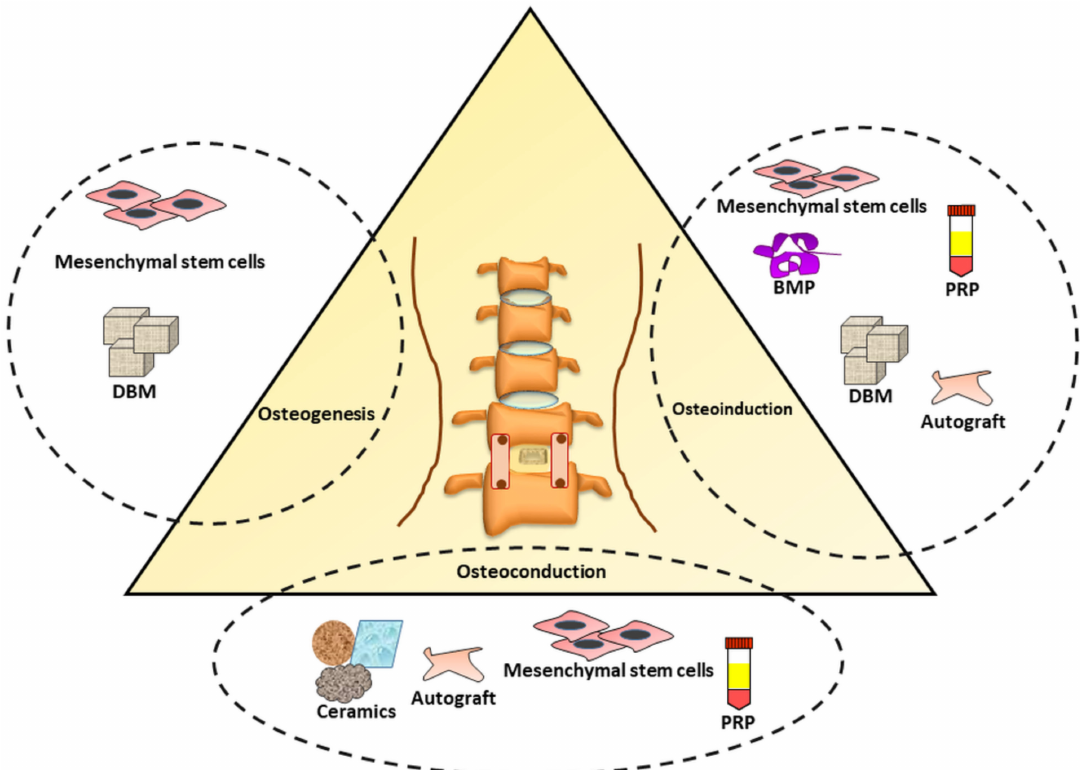
Figure 4. Osteogenic (bone synthesis), osteoinductive (recruiting and stimulating immature cells into preosteoblasts) and osteoconductive (bony growth on a surface) characteristics of bone grafts materials in TLIF-mediated reconstruction. BMP: Bone morphogenetic protein, DBM: Demineralized bone matrix, PRP: Platelet-rich